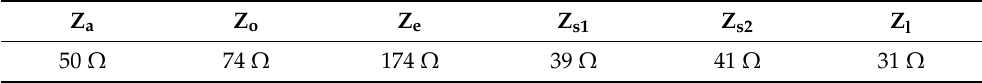
Table 2. Parameter values of the 5 GHz filter different elements from the synthesis. Table 3. Impedance values of the 5 GHz filter different